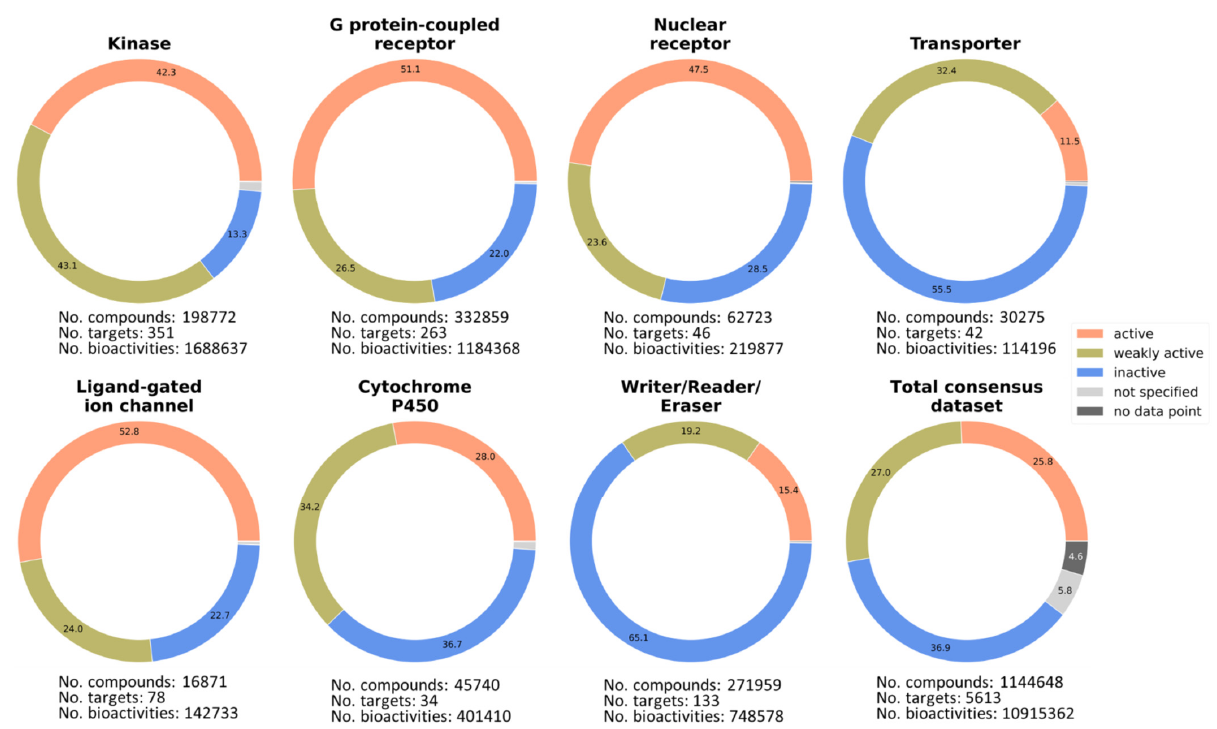
Figure 4. Percentage pie chart of the bioactivity labels of the complete consensus dataset for seven important target families with detailed numbers of associated targets, compounds, and bioactivities. Table 1. Analysis of activity check annotation for bioactivities in at least two source databases. Percentage values refer to bioactivities that were found in at least two